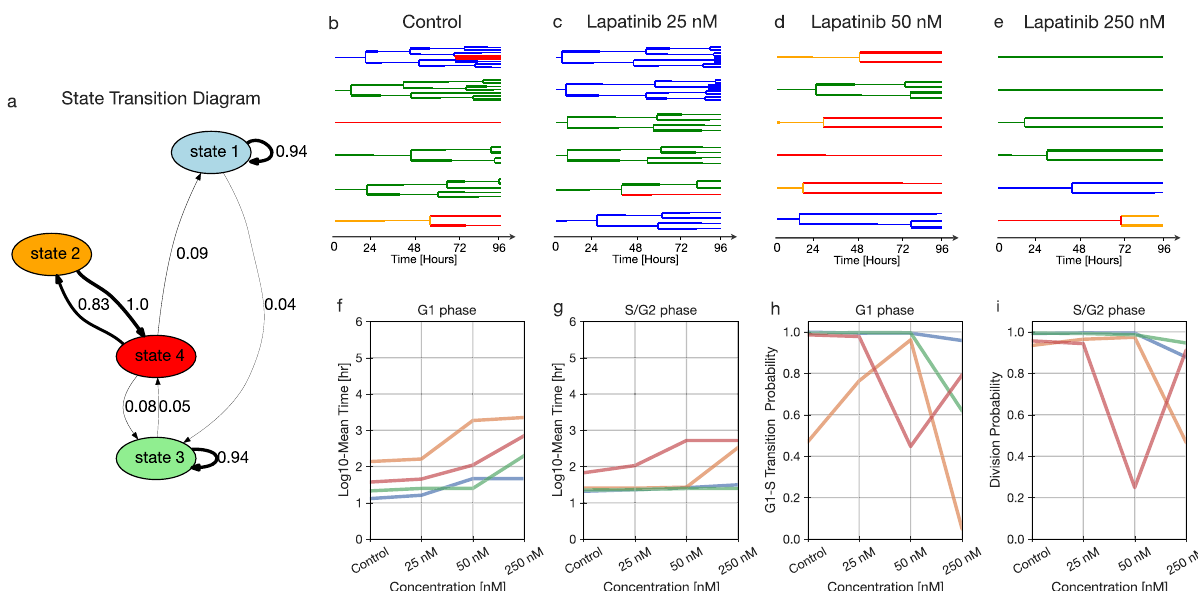
Fig. 8 Lapatinib response is de fi ned by phenotypically-distinct stable and interconverting states. a State transition graph showing the probability of state transitions among the predicted states. Transitions with less than a 0.03 probability have been removed. b – e A sample of lineage trees after fi tting the model and state assignment (control, 25 nM, 50 nM, and 250 nM). f – g The log 10 of fi t mean time of G1 and S/G2 phase durations for different concentrations. h , i The Bernoulli parameter, indicating the probability of G1-to-S phase transition versus cell death ( h ), and the probability of division versus cell death ( i ) for each concentration.